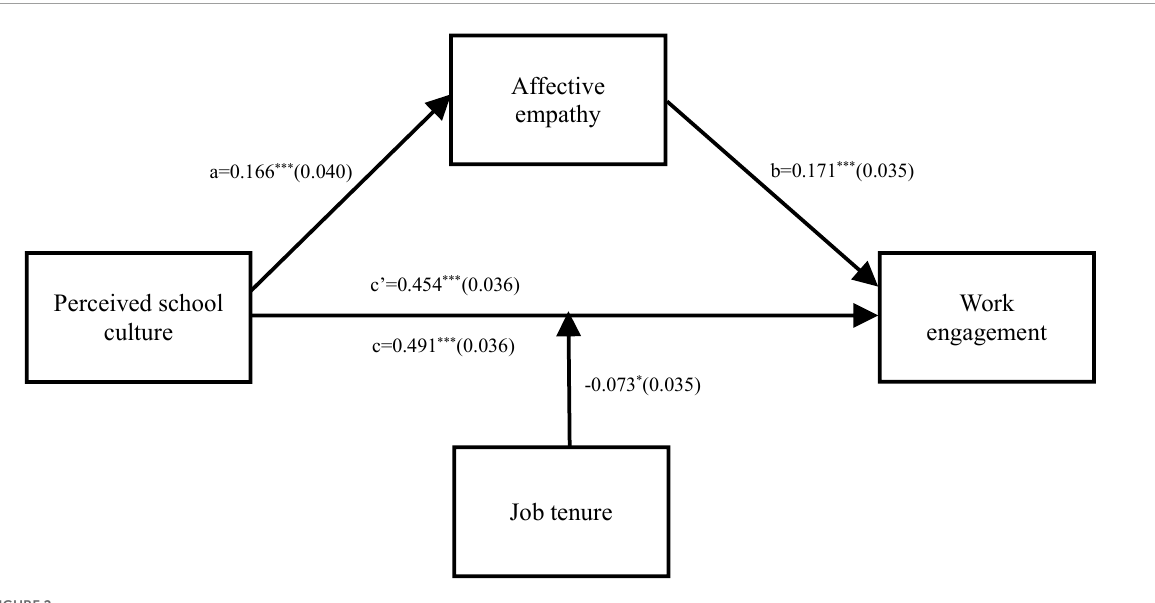
FIGURE2 Standardized coefficients (standard errors) of perceived school culture, affective empathy, work engagement, and job tenure. * p < 0.05, *** p <